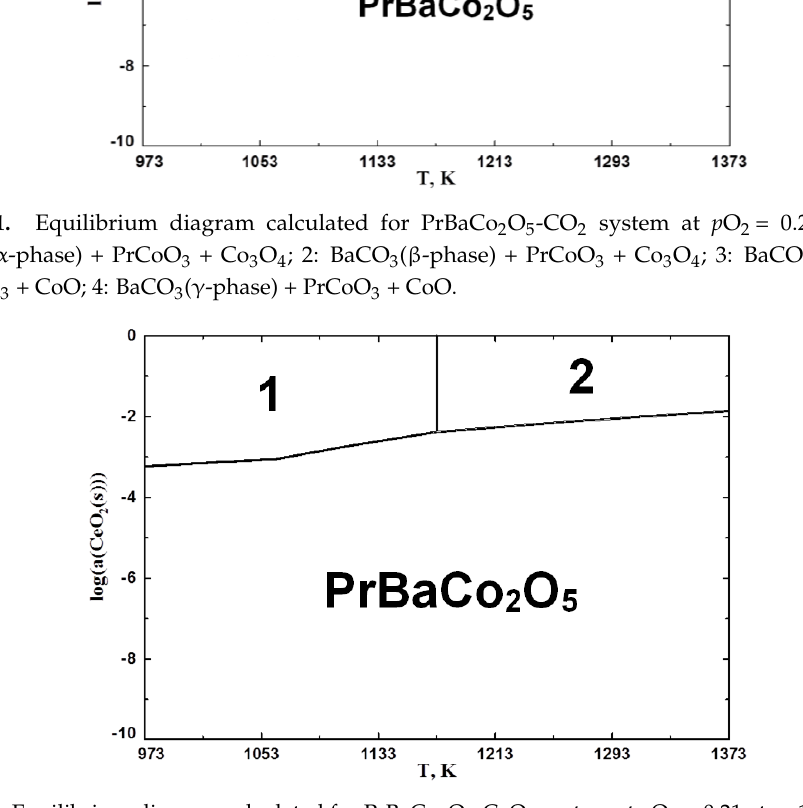
Figure 2. Equilibrium diagram calculated for PrBaCo 2 O 5 -CeO 2 system at p O 2 = 0.21 atm. 1: BaCeO 3 + PrCoO 3 + Co 3 O 4 ; 2: BaCeO 3 + PrCoO 3 + CoO.